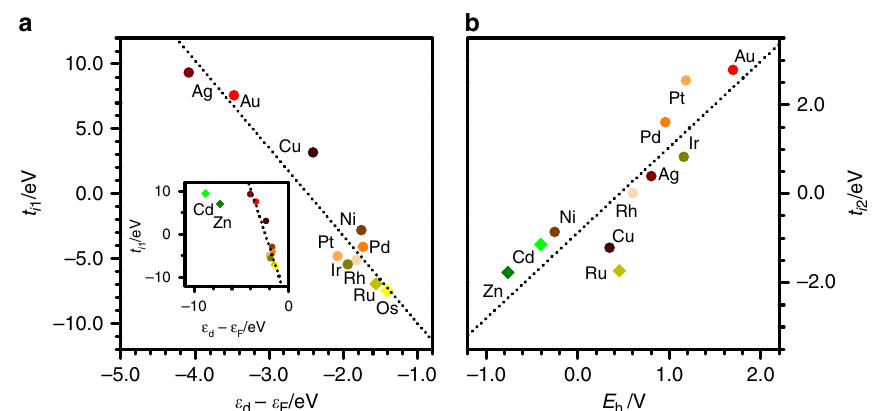
Fig. 3 Interpretation of metal descriptors in physical terms. First and second descriptors for the metals, t i 1 and t i 2 , plotted against a the d -band center and b the reduction potential 50 , respectively. The inset shows that d -band center controls the adsorption energy on late transition metals (groups 8 – 11) 30,31 , but it cannot describe the behavior of Zn and Cd. Additional data and plots are provided in Supplementary Table 2 and Supplementary Figs. 1 and